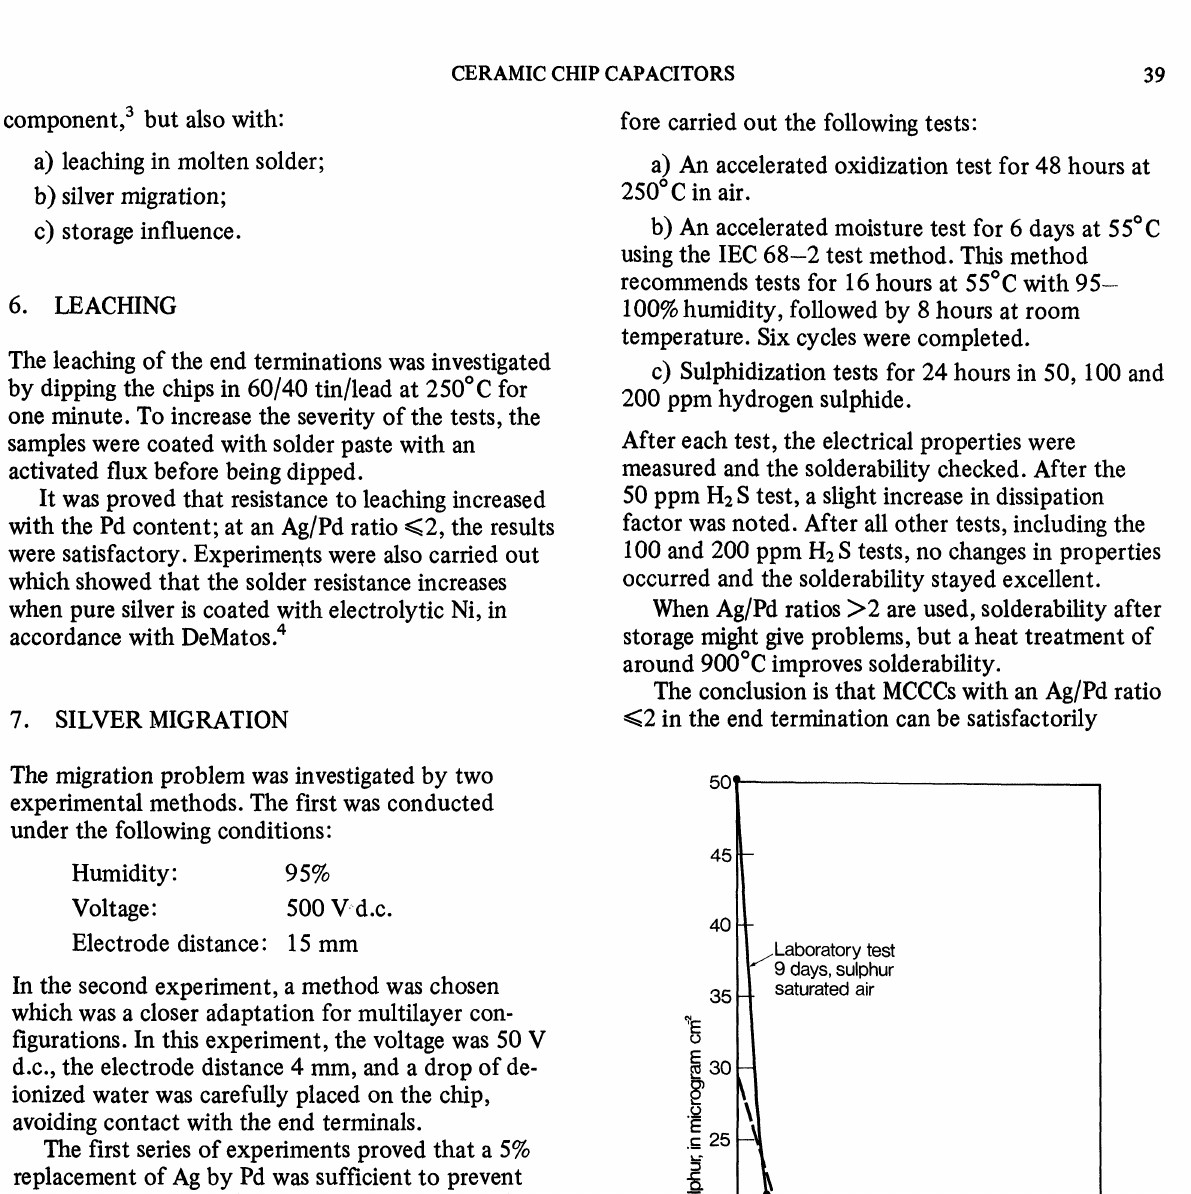
weeks indoor exposure New York City